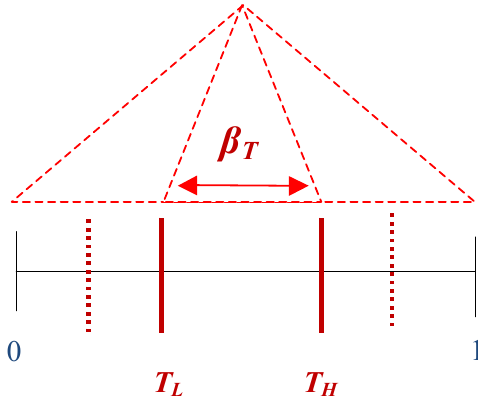
Fig. 1. Description of the parameter to adapt the